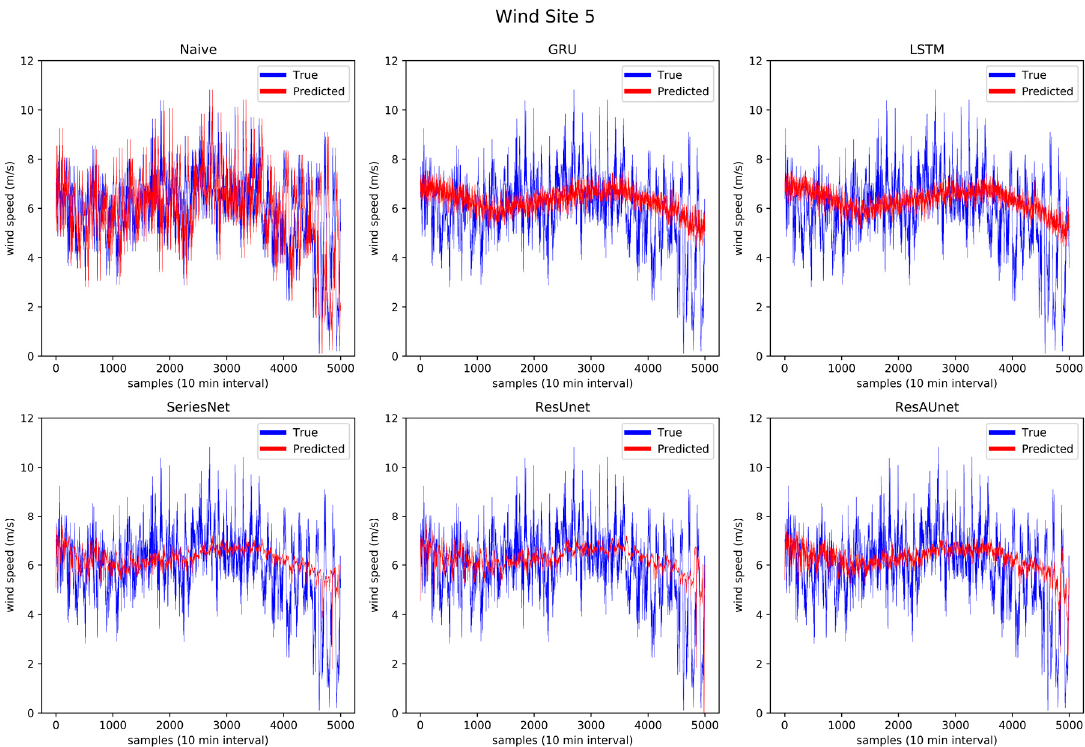
Figure 17. Prediction results of the six models for wind Site 5. Energies 2020 , 13 , x FOR PEER REVIEW